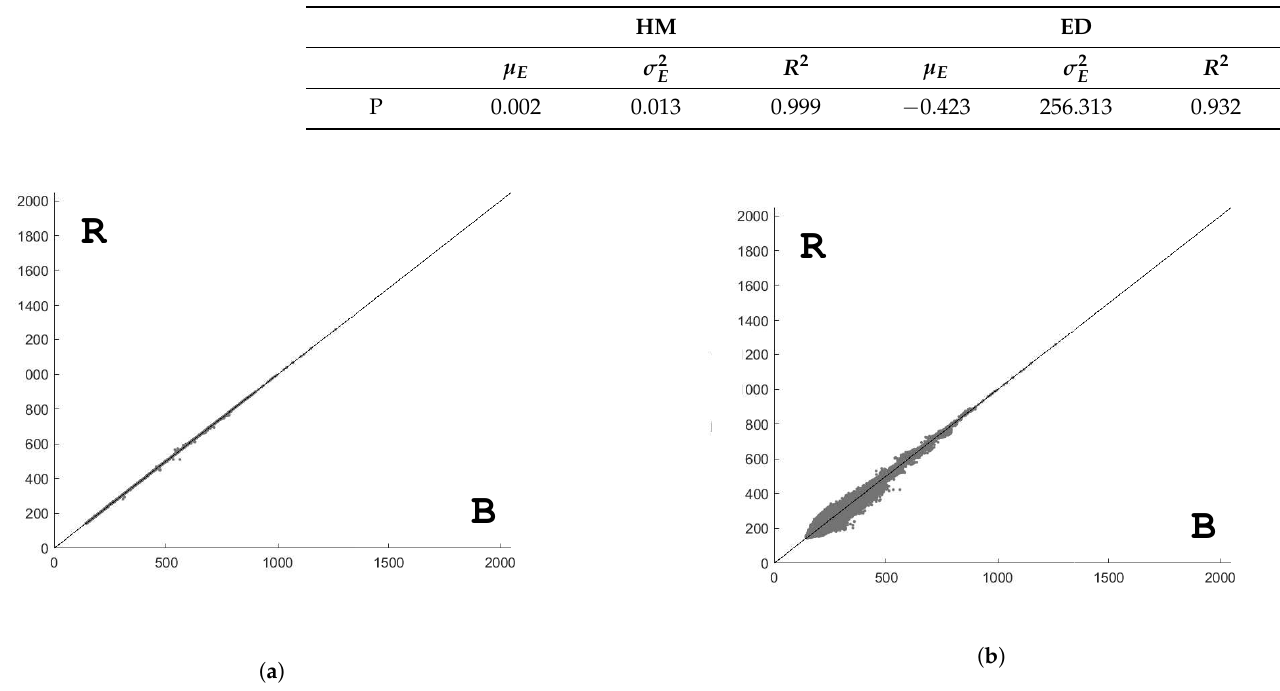
Figure 6. Panchromatic self-validation test—radiometric reconstructions; B = Base intensity values, R = Reconstructed intensity values. ( a ) Scatter plot of Panchromatic values—HM based reconstruction; ( b ) scatter plot of Panchromatic values—ED based